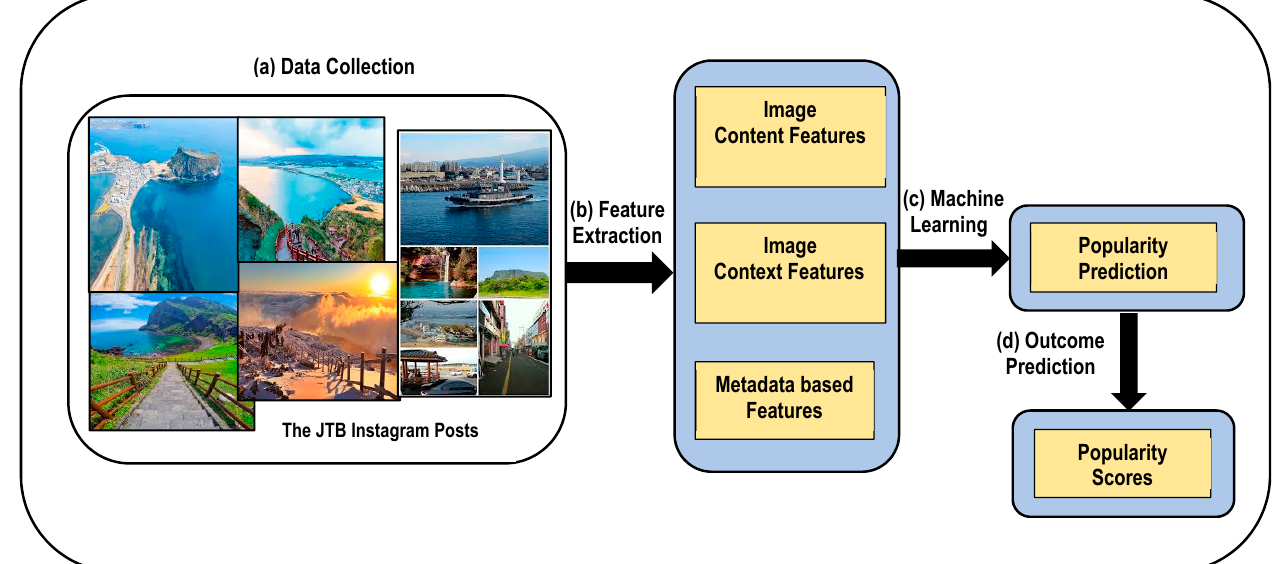
Figure 1. Our proposed framework for determining the popularity of tourist destinations related postings on Instagram ( a ) the data collection part which consists of the Jeju Tourism Board (JTB) official Instagram posts. ( b ) Feature extraction part, which consists of producing image content, image context, and metadata-based features ( c ) Machine Learning techniques are applied here to the training set to build popularity prediction model ( d ) Predictive model is applied here to predict the popularity of test set images.